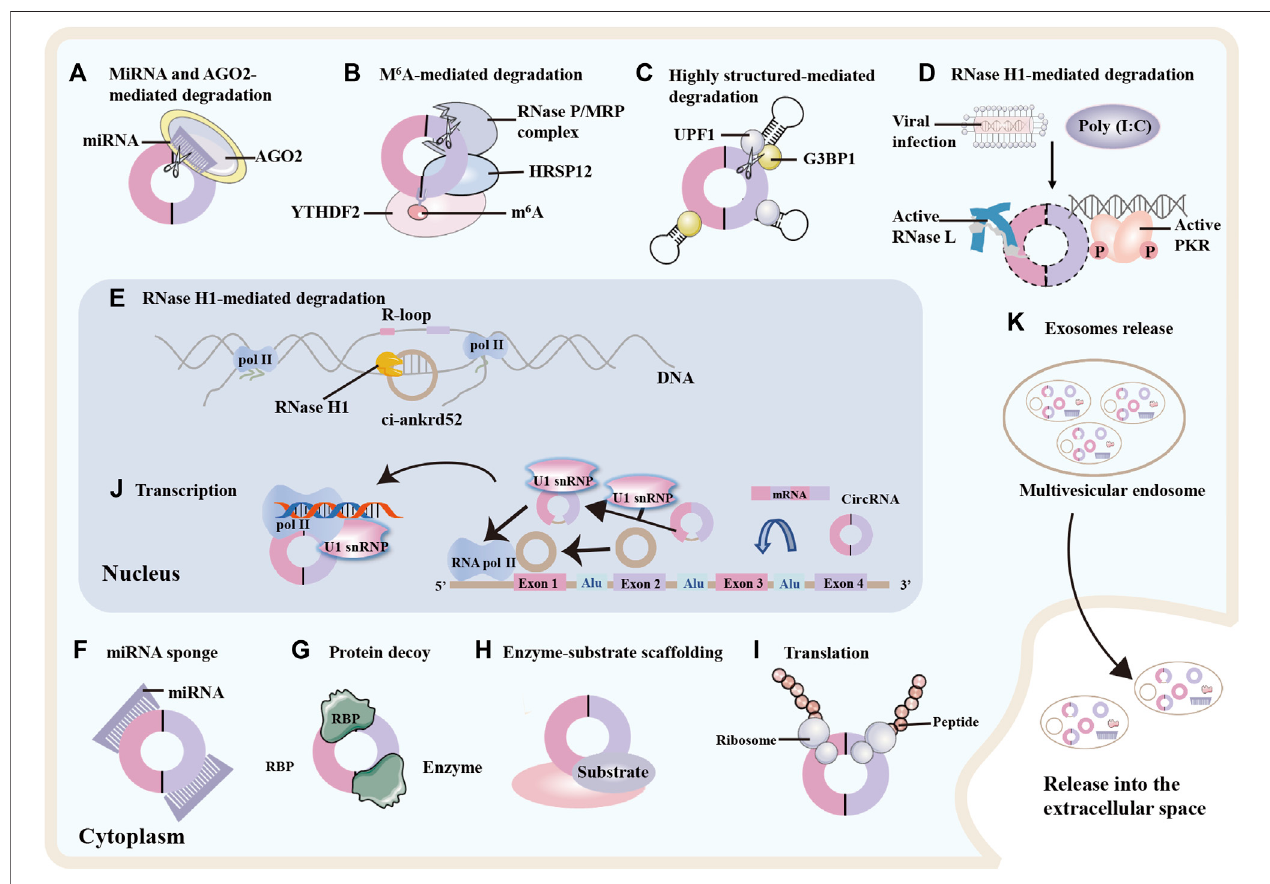
FIGURE 2 | circRNAs degradation, functions and exosomes release. Degradation of circRNAs: (A) Speci fi c microRNA (miRNA) direct binding to circular RNA (circRNA)facilitatescleavageofthecircRNAbyargonaute2(AGO2). (B) N 6 -methyladenosine(m 6 A)-modi fi edcircRNAscanbecleavedbytheYTHDF2-HRSP12-RNase P/MRP complex. (C) The RNA-binding proteins UPF1 and its associated protein G3BP1 bind and regulate circRNA with highly-structured 3 ′ UTRs, promoting their cleavage by thehelicase activity ofUPF1. (D) Uponviral infection, RNase L isactivated and degrades the circRNAs, thereby releasing and activatingprotein kinase R (PKR) and decreasing global circRNA levels. (E) In the nucleus, RNase H1 degrades ciankrd52 dependent upon R-loop, thereby promoting RNA polymeraseII (Pol II) transcriptional elongation at ciRNA-producing loci. CircRNAs functions. (F) circRNAs can function as miRNA sponge by binding miRNA and inhibiting the expression of miRNA-mediated target messenger RNA (mRNA). (G) circRNAs can interact with RNA binding proteins (RBPs) and in fl uence protein expression and function. (H) circRNAs can act as protein scaffolds for enzyme-substrate to modulate protein-protein interactions. (I) circRNAs with ribosome entry sites can be translated into proteins. (J) Inthenucleus,circRNAscaninteractwithsmallnuclearribonuleoproteinU1(U1snRNP)orpromotePolIIelongation machinery toenhanceRNAPolII,then promoting gene expression. Exosomes release. (K) circRNAs can be enriched in exosomes and released into the extracellular environment upon exocytic fusion of multivesicular endosomes with the cell